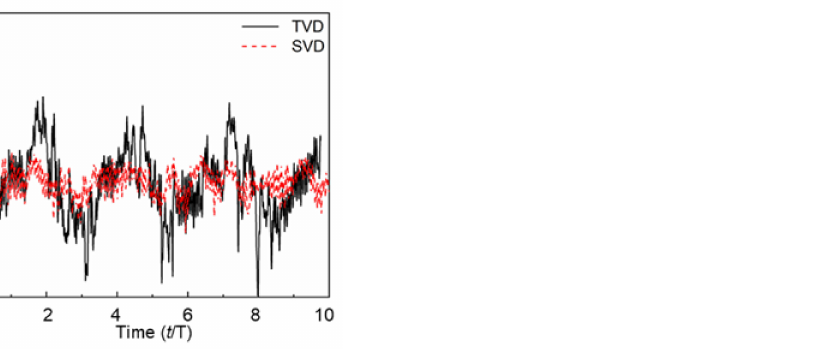
Figure 17. Comparison of unsteady pressure at 0.95 span of diffuser vane leading-edge ( ϕ = 0.7 Q d ).